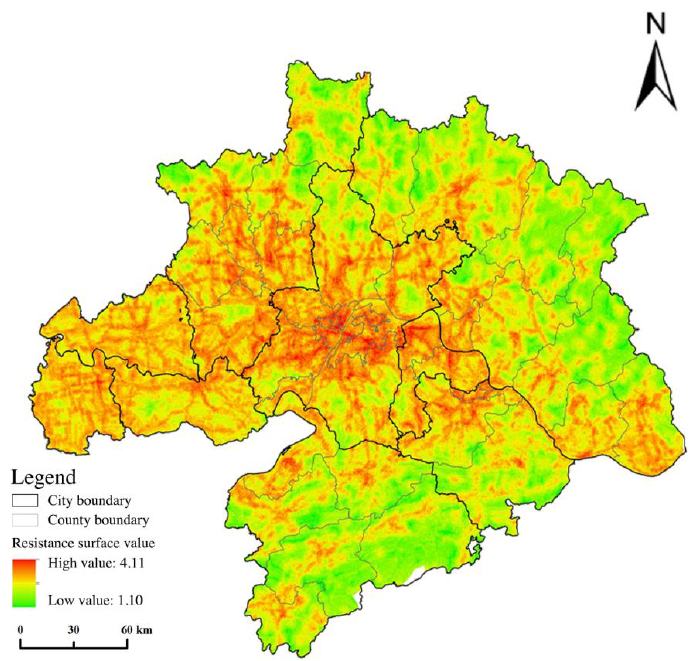
Figure 9. The WUA ecological resistance